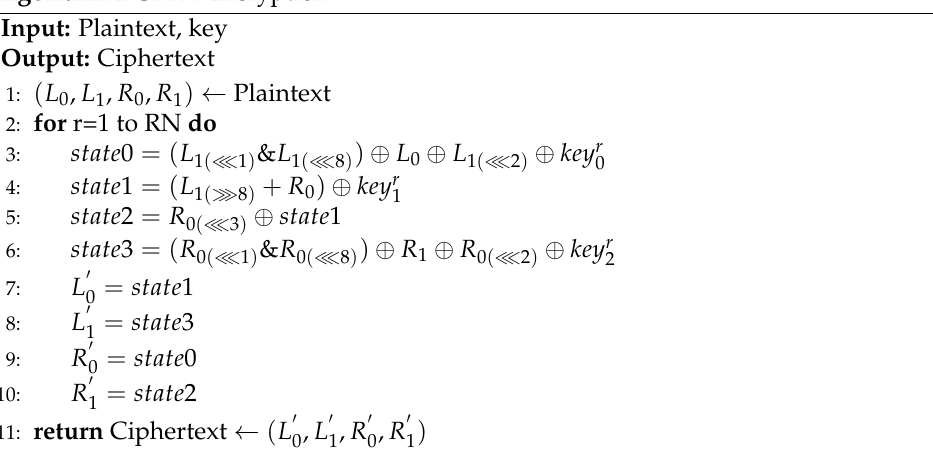
Figure 4. The flow of F ADL and F ADR . Algorithm 1 GFRX